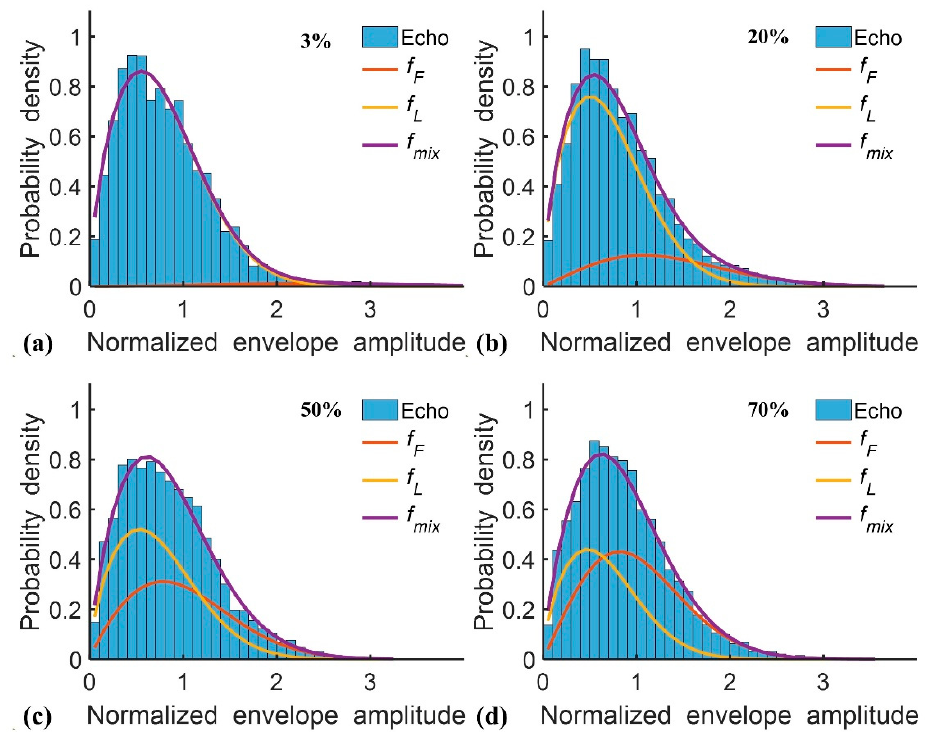
Figure 2. Probability density distributions of the DND mode constructed using the Kullback–Leibler (KL) method, representing that the backscattered signals contributed by lipid droplets (i.e., f F ) gradually approach the Rayleigh distribution with an increasing grade of hepatic steatosis. ( a ) 3%; ( b ) 20%; ( c ) 50%; ( d ) 70%.